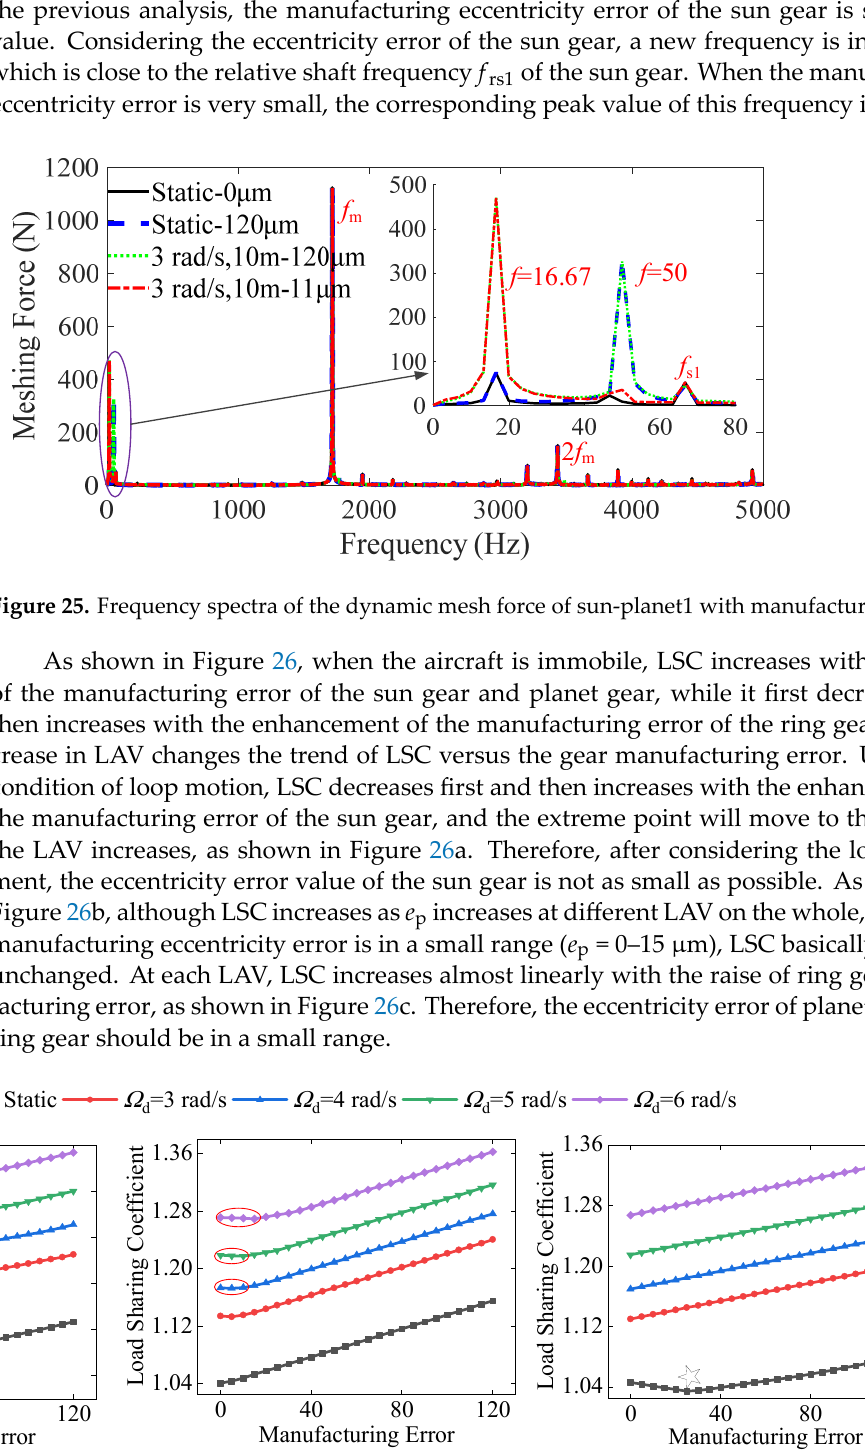
Figure 26. Influence of gear manufacturing eccentricity error on LSC at different LAV. ( a ) Sun gear; ( b ) Planet gear; ( c ) Ring gear.